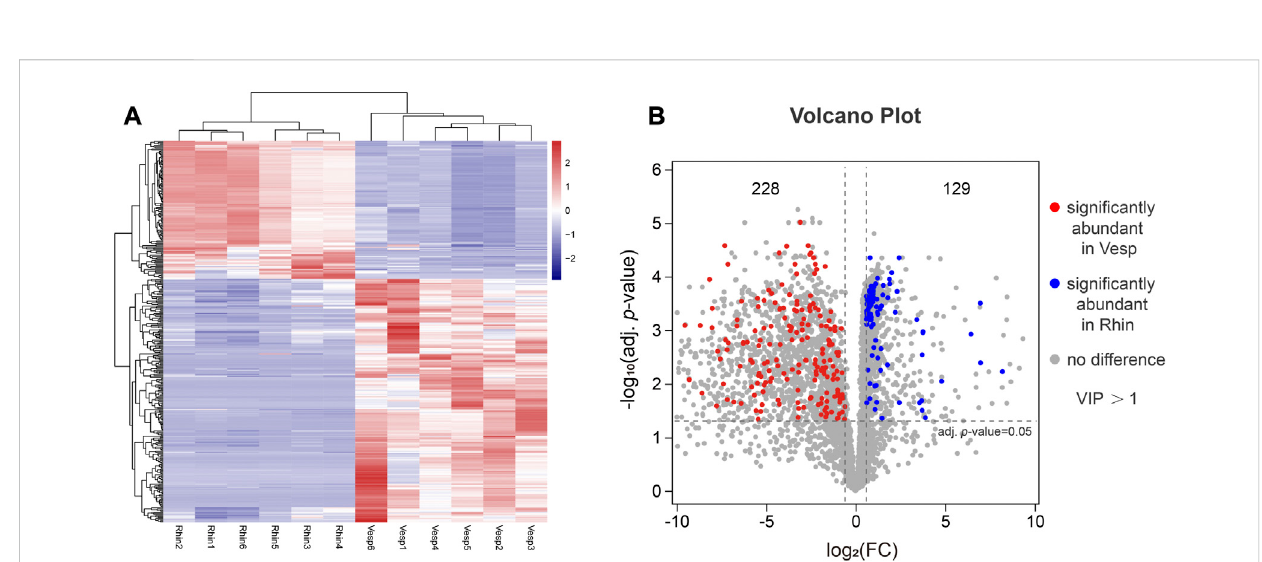
FIGURE 5 Visualization of DAMs present at signi fi cantly different levels in R. sinicus and V. sinensis . (A) Heatmaps of DAMs with the abundance levels in all cochlear samples. Red indicates an increase, blue indicates a decrease, rows indicate different metabolites, and columns indicate different samples. (B) Volcano plot of